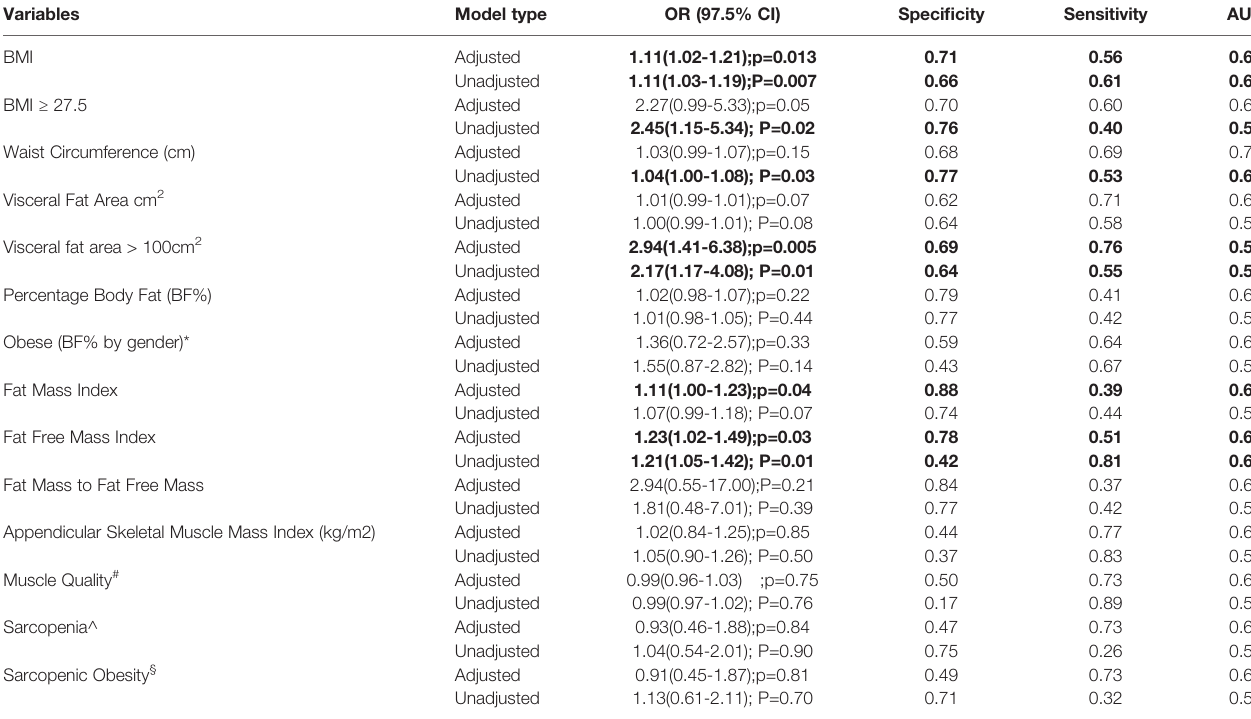
TABLE 3 | Sarcopenic obesity, obesity, sarcopenia de fi nitions and body composition analysis associations with Diabetes Mellitus status.